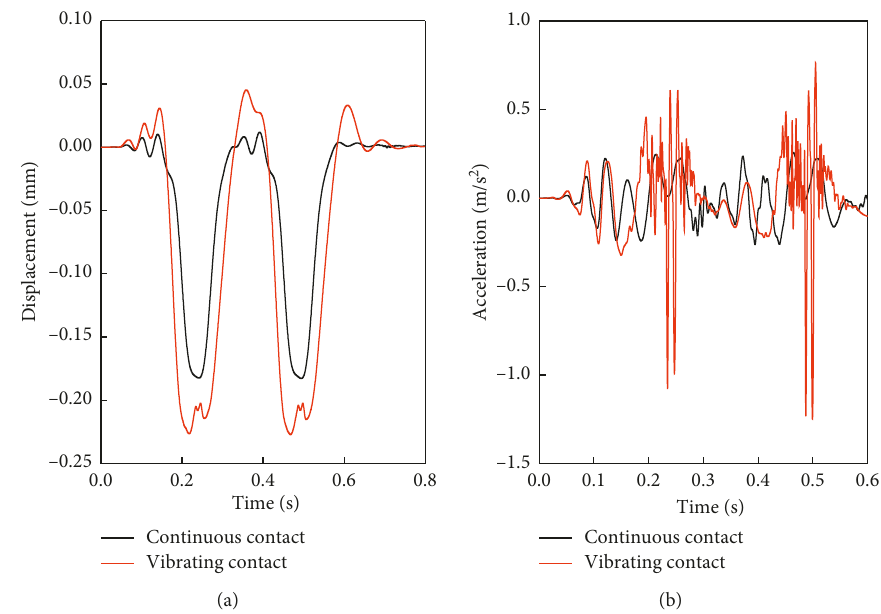
Figure 8: Dynamic displacement and acceleration of the concrete base in the states of continuous contact and vibrating contact: (a) dis- placement and (b)